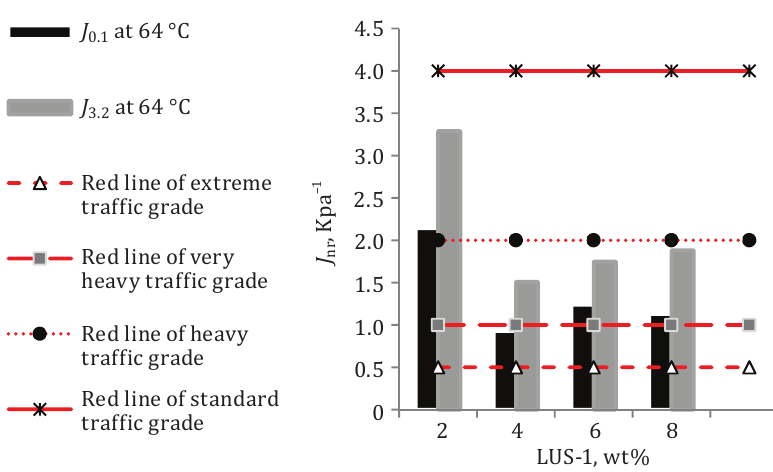
Figure 12. Effect of stress levels on non-recoverable creep compliance of asphalt binders at 64 °C